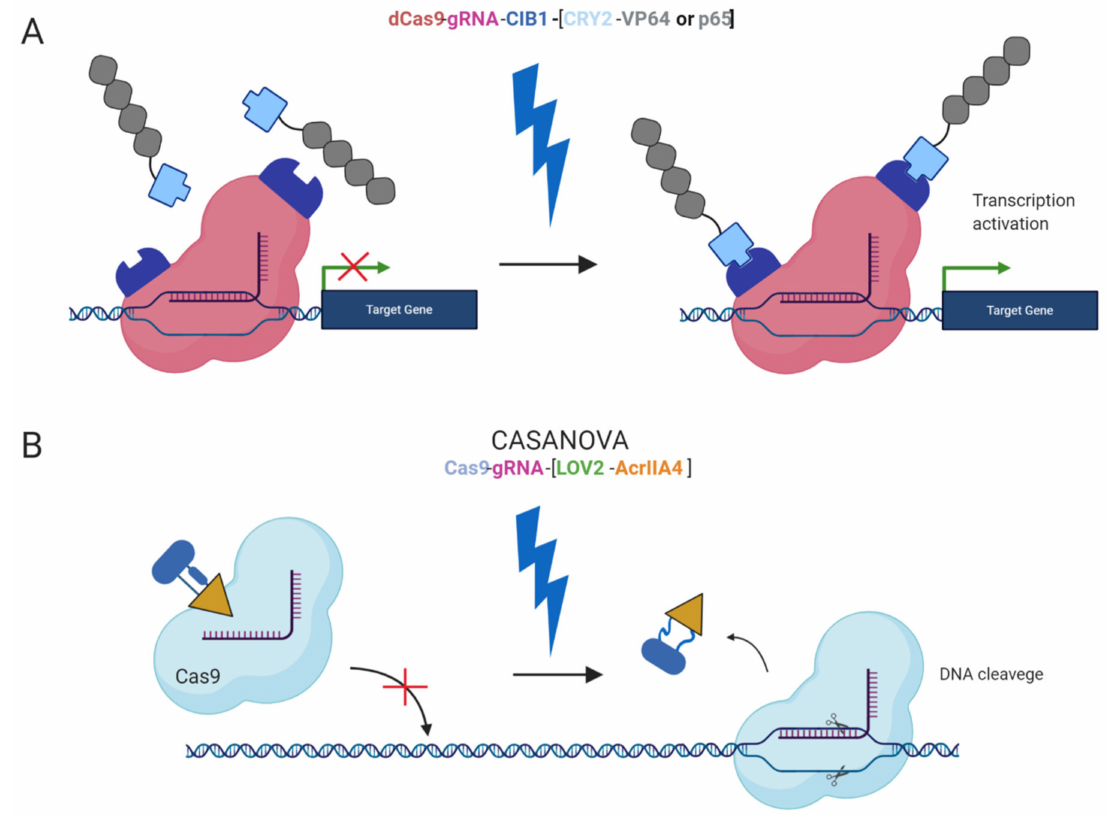
Figure 2. Light inducible CRISPR / Cas9 systems. ( A ) An inducible system based on blue light-dependent interaction between cytochrome 2 and CIB1 protein fused to CRISPRa components dCas9 and the e ff ector (VP64 or p65). During exposure to the blue light two components are bound together and fully functional, upon removal of the blue light the complex is decomposed; ( B ) CASANOVA system, the blue light-inducible system controlling Cas9 nuclease activity via inhibitor LOV2-AcrIIA4. In the absence of the blue light, the inhibitor blocks Cas9 and prevents it from the binding the target sequence. In the presence of the blue light, the inhibitor is destabilized and released from Cas9 protein. Subsequently, Cas9 is active and executes DSB in the target locus when the blue light is removed the inhibitor binds back to Cas9.The chemically inducible systems are ligand-dependent. The interaction between the e ff ector domain and dCas9 is conditioned by the presence of a ligand and two ligand-binding domains, linking two epi-editor components. Again, one of the binding domains fuses with the e ff ector and the other with dCas9. In the presence of a ligand, both binding domains interact with the ligand and form a stable heterodimer resulting in the formation of an active epi-editor complex. Examples of ligand-binding domains are FK506 binding protein 12 (FKBP), and FKBP rapamycin binding protein (FRB) interacting together via rapamycin molecule (Figure 3A) [100], abscisic acid-induced dimerization of ABI and PYL1 domains (Figure 3B) [101], or gibberellin-induced dimerization of GID1 and GAI (Figure 3B)